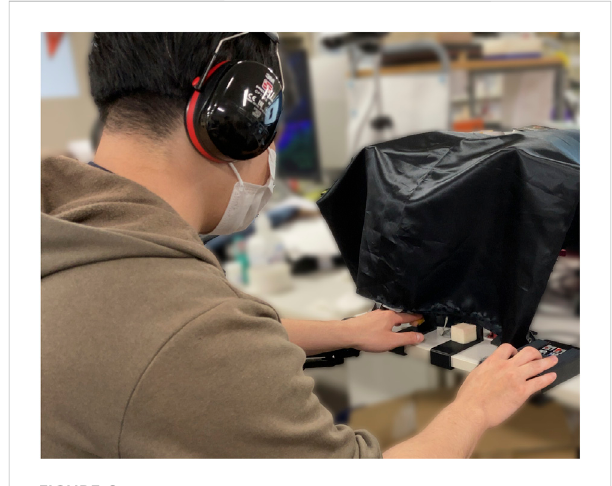
Overview of the point of subjective equality